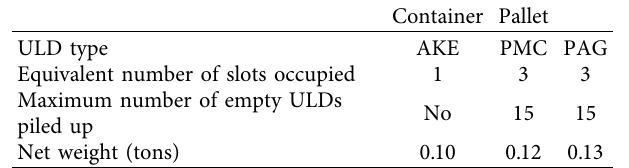
Table 2: ULD data.